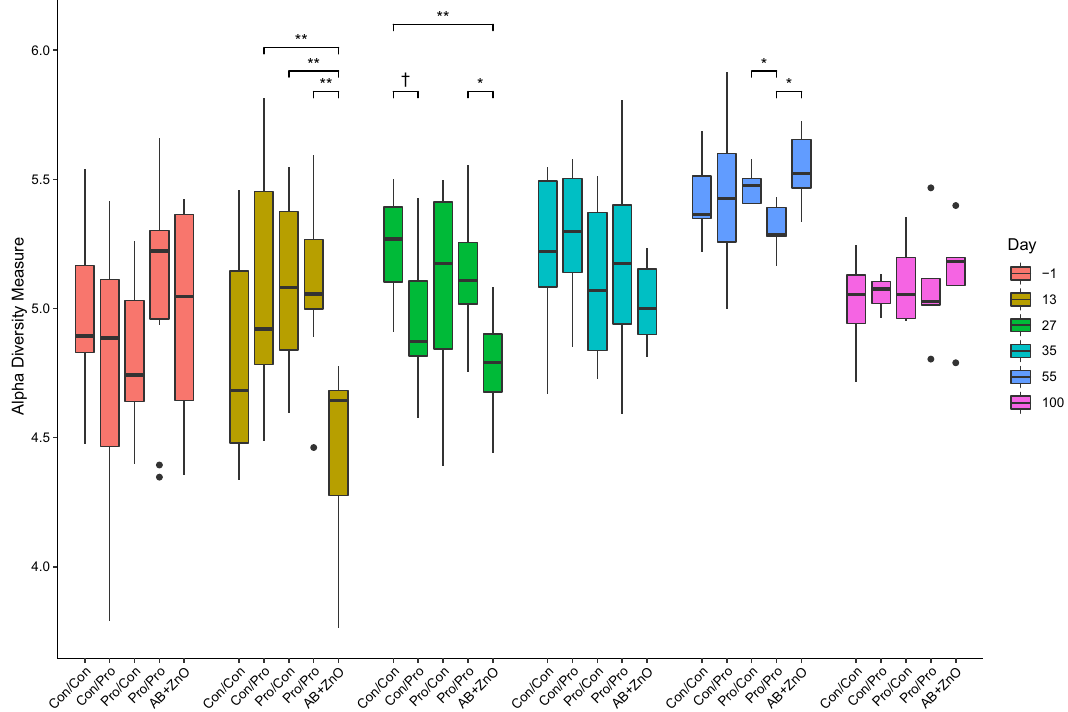
Figure 1. Shannon α-diversity of the faecal microbiota of pigs supplemented with Bacillus altitudinis WIT588 spores during 1st stage and/or 2nd stage weaning or with antibiotic (AB) + ZnO during 1st stage weaning or un-supplemented during both stages. Treatments (1st stage weaning period/2nd stage weaning period) are as follows: Con/Con, Con/Pro, Pro/Con, Pro/Pro, and AB + ZnO; where Con = control, Pro = probiotic and AB + ZnO = antibiotic + ZnO. Colours indicate the time point post-weaning at which pigs were sampled. Significant differences between treatments within each sampling time point are indicated as ** ( P ≤ 0.01), * (0.01 < P ≤ 0.05) and † (0.05 < P ≤